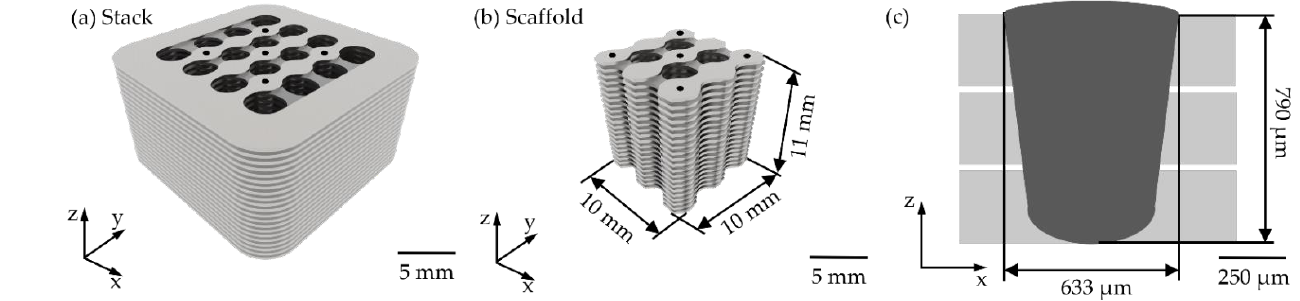
Figure 3. Designed scaffold ( a ) stack, ( b ) scaffold, and ( c ) laser micro-spot weld design .